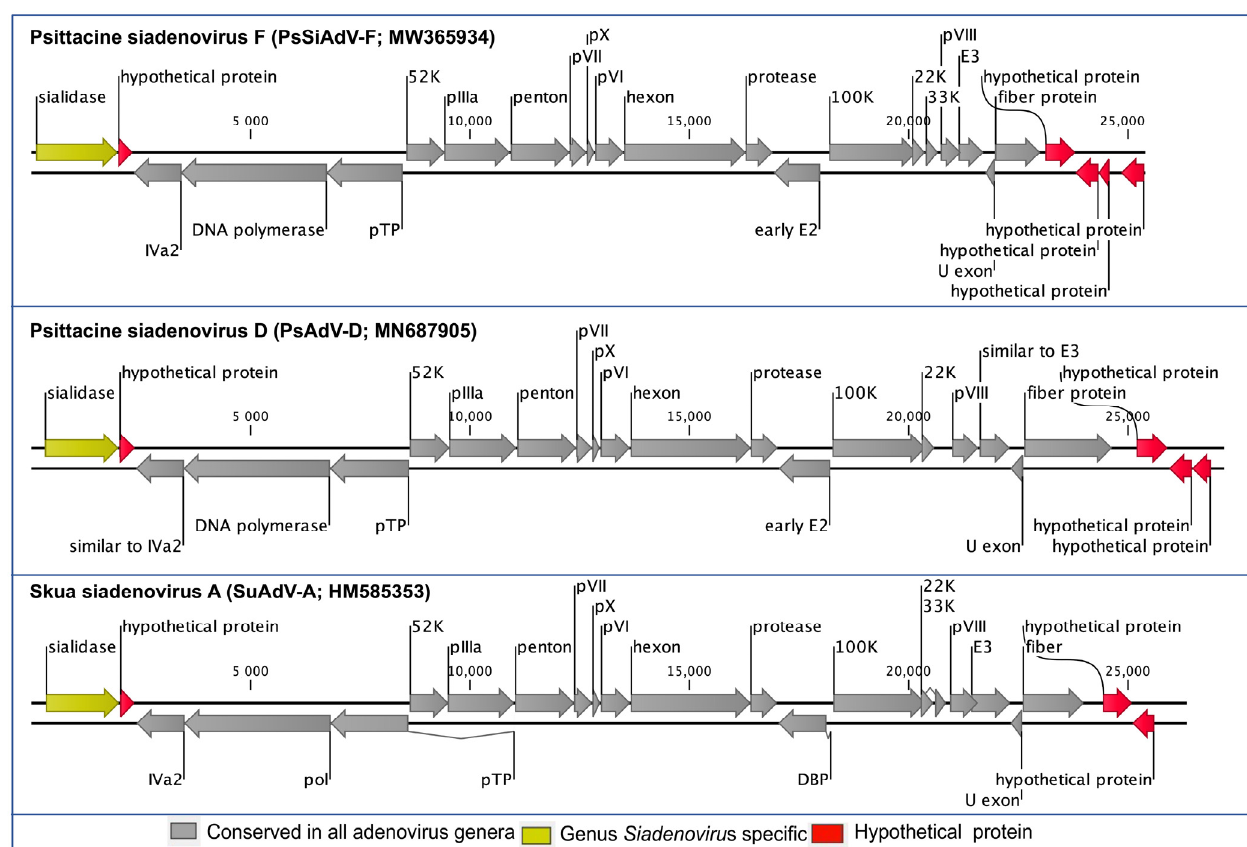
Figure 1. Schematic illustration of the selected siadenoviruses. Schematic map of the psittacine siadenovirus F (PsSiAdV-F, GenBank accession no. MW365934), in comparison with psittacine siadenovirus D (PsAdV-D; GenBank accession no. MN687905) and Skua siadenovirus A (SuAdV-A; GenBank accession no. HM585353) using CLC Genomic Workbench (version 9.5.4, CLC bio, a QIAGEN Company, Prismet, Aarhus C, Denmark). The arrows symbolise adenovirus genes and open reading frames (ORFs) predicted to code for proteins, indicating their direction of transcription. Each gene or ORF is colour coded, as indicated by the colour key in the legend. Table 1. Predicted protein-coding genes of PsSiAdV-F.